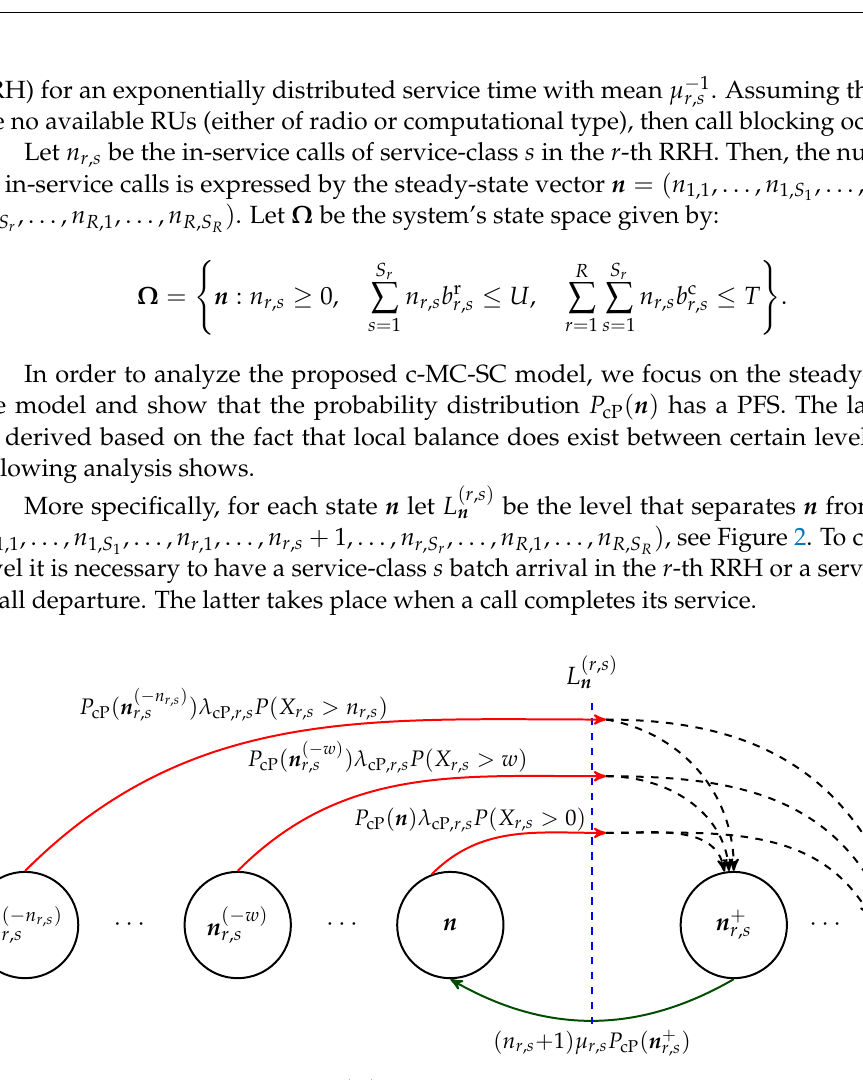
( r , s ) n of the c-MC-SC